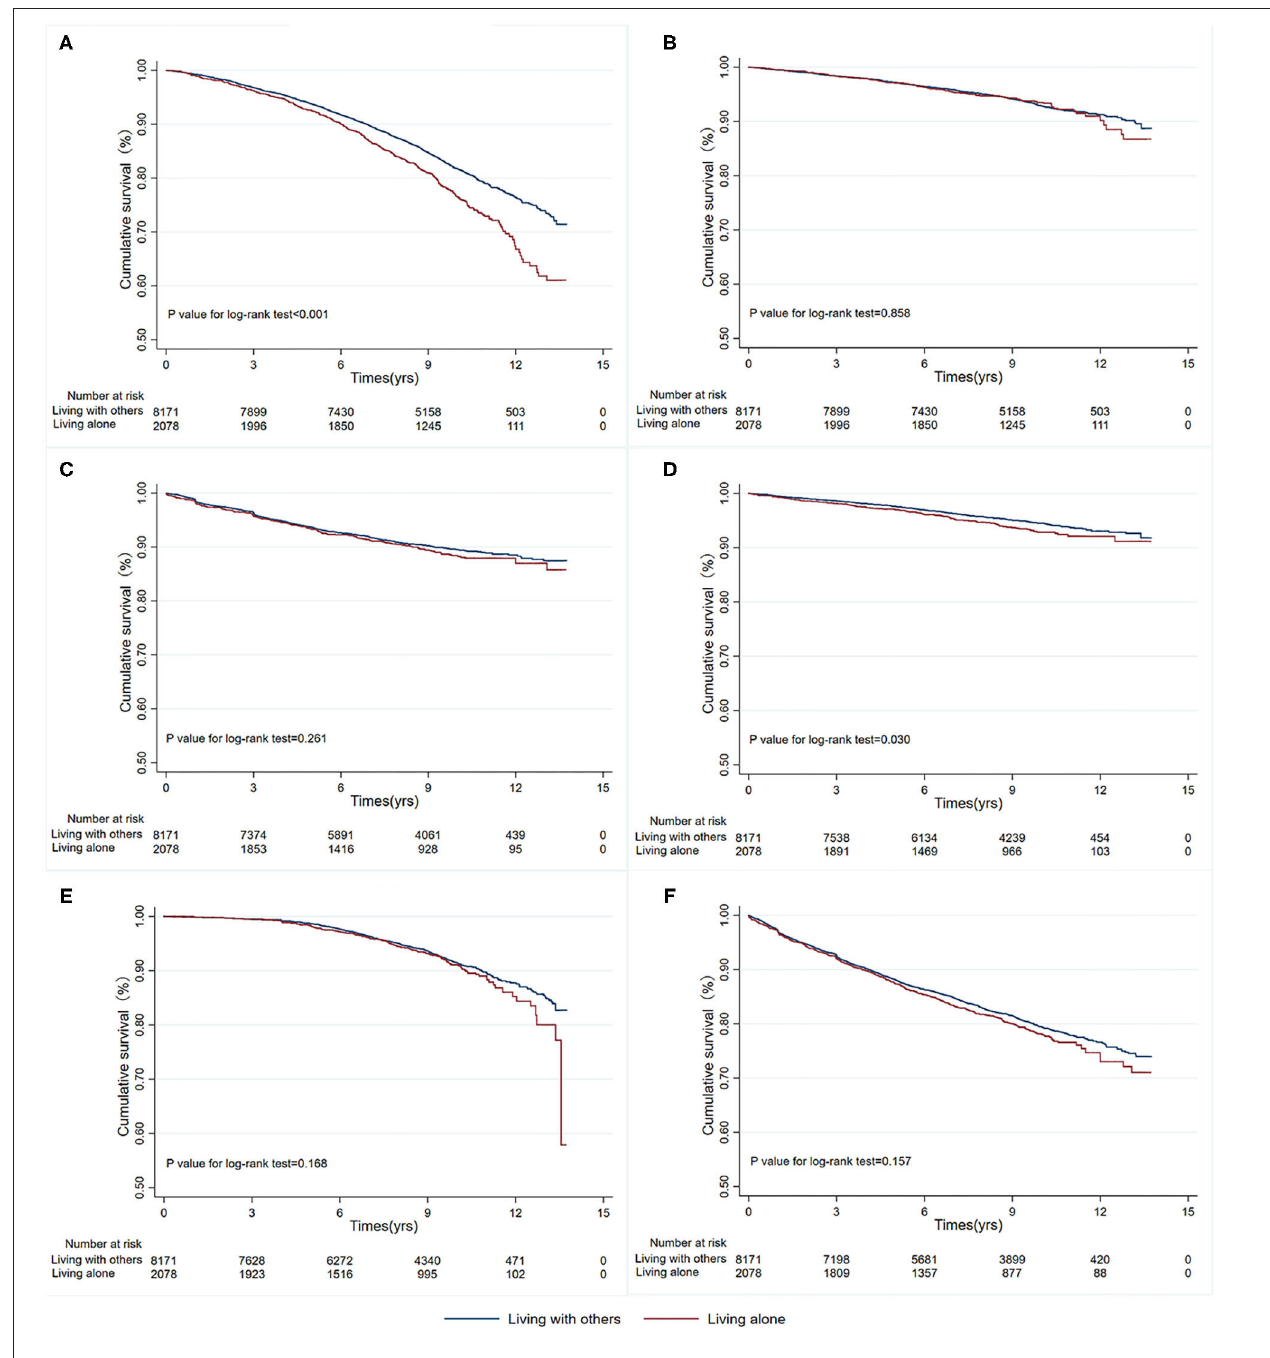
FIGURE 1 | Kaplan-Meier survival curves for primary and secondary outcomes by living status. (A) All-cause mortality; (B) Cardiovascular mortality; (C) Non-fatal MI; (D) Non-fatal stroke; (E) CHF; (F) CHD. MI, myocardial infarction; CHF, congestive heart failure; CHD, coronary artery